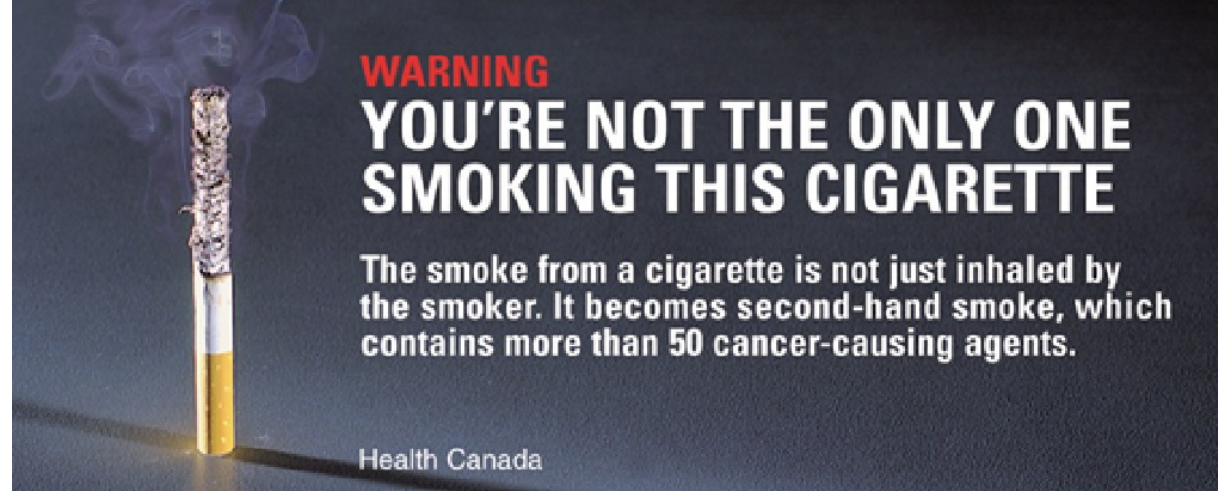
Figure 3. START control message. Source: Health